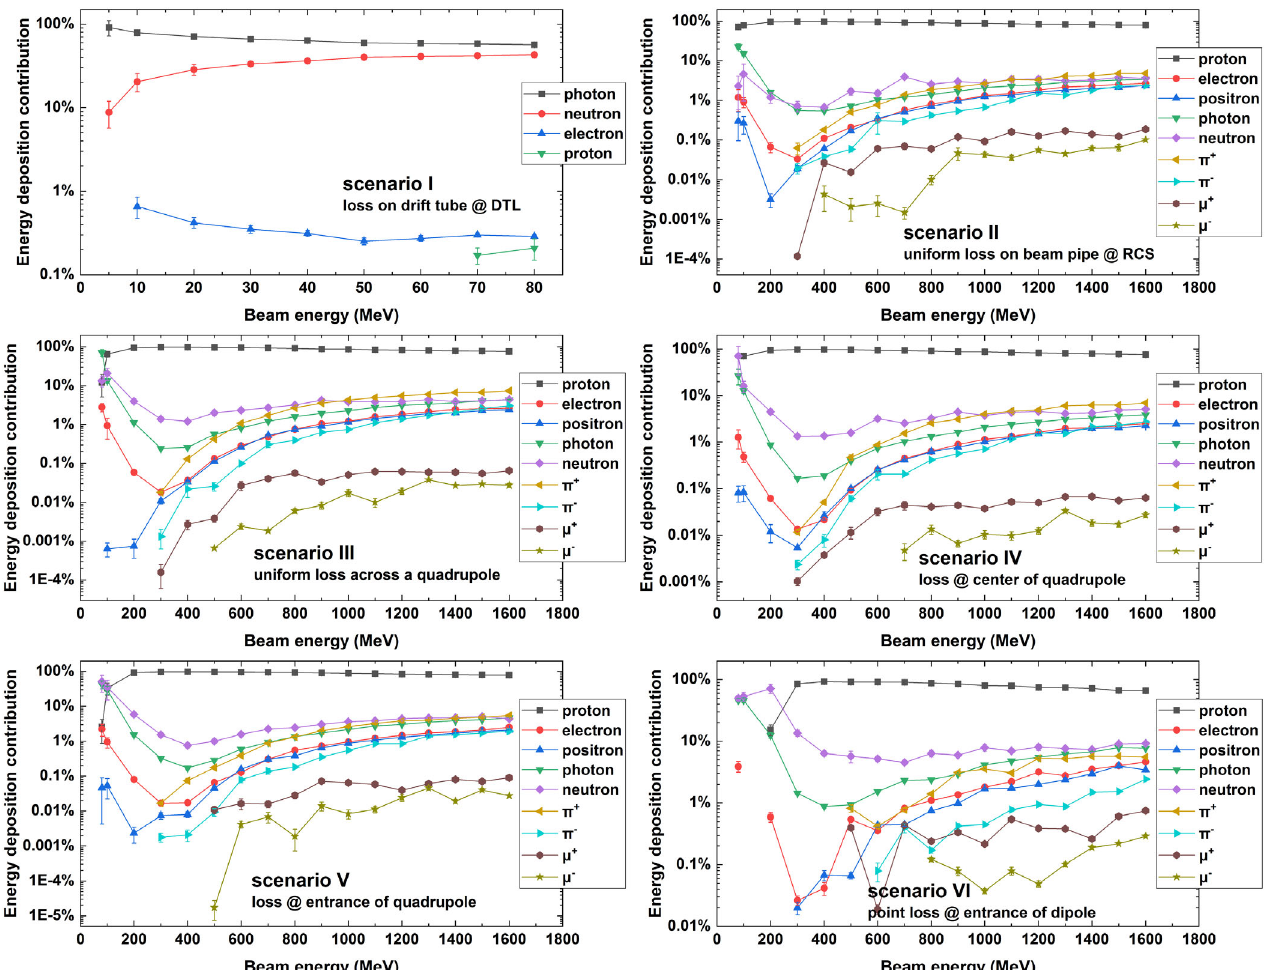
FIG. 21. Energy deposition contributions from different particles for the six assumed